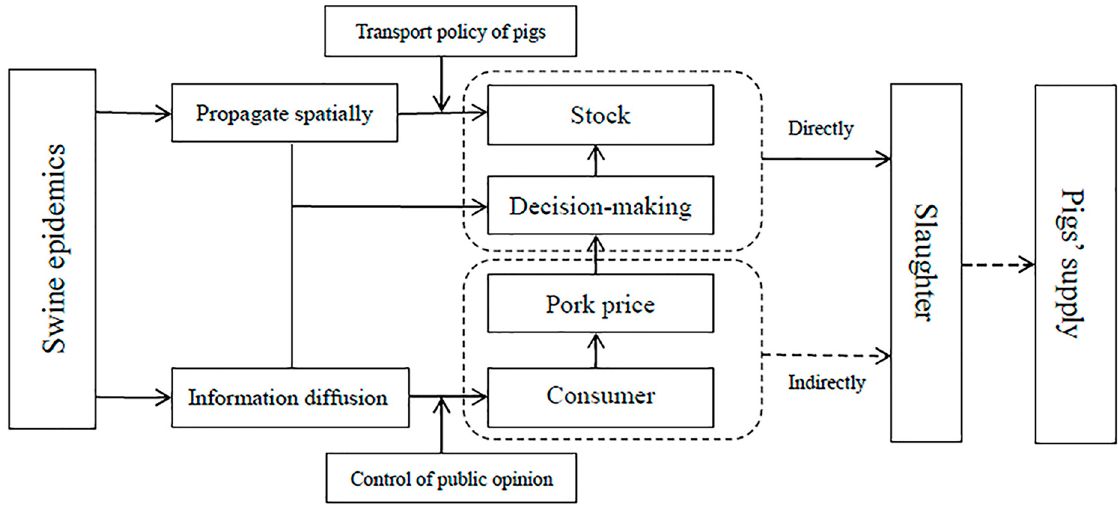
Figure 1. The conduction path of the impact of swine epidemics on the pig supply.